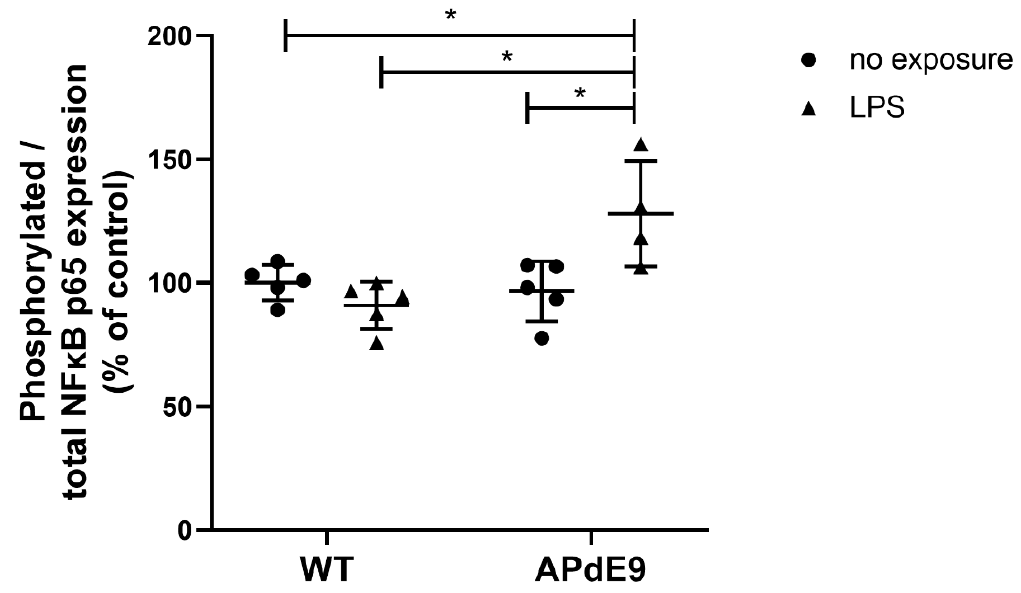
Figure 2. Phosphorylated/total NF κ B p65 expression in the cerebral cortical tissue in saline-treated female wild-type (WT) control mice vs. female WT mice treated with LPS, and female APdE9 mice treated with either saline or LPS. The line represents group mean and whiskers—the SD ( n = 4–5 per group). The statistical significance of changes in gene expression between the groups was analyzed by a Kruskal–Wallis test followed by a Dunn’s multiple comparisons post-hoc test. Statistically significant differences are marked with asterisks, where * indicates p < 0.05.